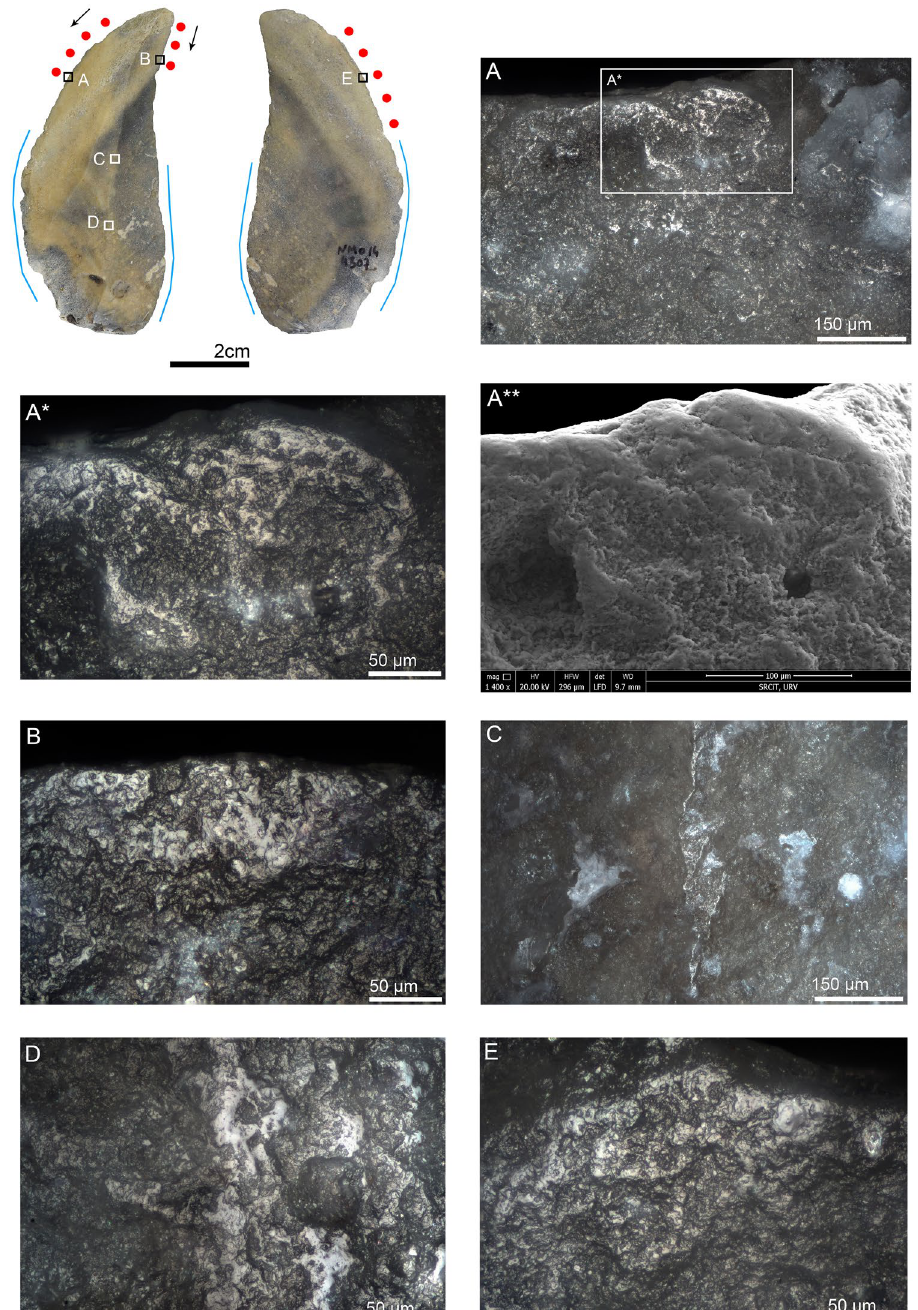
Figure 3. Non-Levallois point NMO14 4307 interpreted as a hafted hide-cutting knife, likely for skinning. ( A ) polish and edge rounding on the distal dorsal left edge, 200 ×; ( A* ) close-up of the previous image in which the rough texture and dull appearance of polish is appreciable, as well as some pits and well-developed edge rounding, 500 ×; ( A** ) same polish observed with SEM in which the hihgly developed polish and edge rounding are appreciable, 1400 ×; ( B ) rough-dull polish on the dorsal distal right edge, 500 ×; ( C ) hafting polish on the mesial dorsal right ridge, 200 ×; ( D ) well-developed hafting polish on the proximal dorsal right ridge, 500 ×; ( E ) rough-dull polish and edge rounding on the ventral distal left edge, 500 ×. *Edge areas with micro-wear (polish and edge rounding) are represented by red dots. Black arrows indicate the direction of work. The same markers and color codes are valid for the rest of the